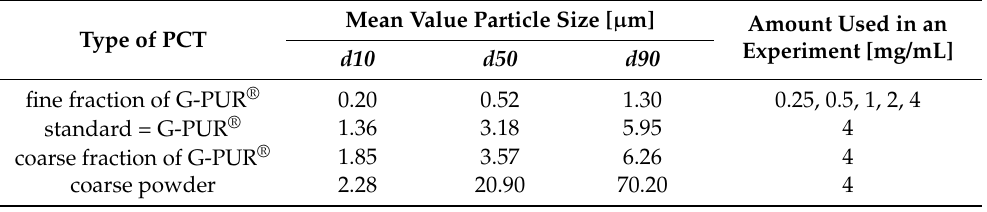
Table 3. Particle size distributions used to determine the different adsorption capacities of gliadin on PCT and the amounts used in experiments. The various fractions of G-PUR ® were determined as coarse, standard, and fine. Moreover, another coarser fraction was used, called coarse powder. Note that standard is the particle size usually used for experiments. Analyses were performed using a Mastersizer 2000 equipped with software version 5.31 (Malvern Instruments Ltd., Malvern, UK).